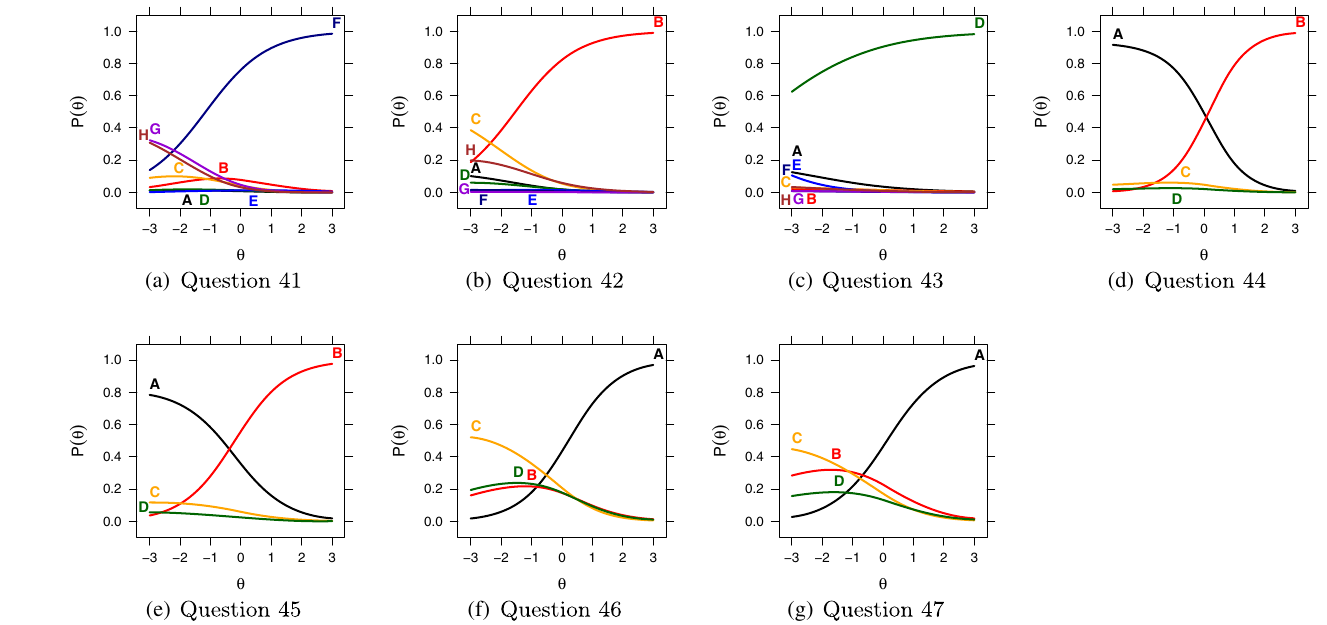
FIG. 8. IRT plots from the 2PL-NRM nested logit model for questions 41 –